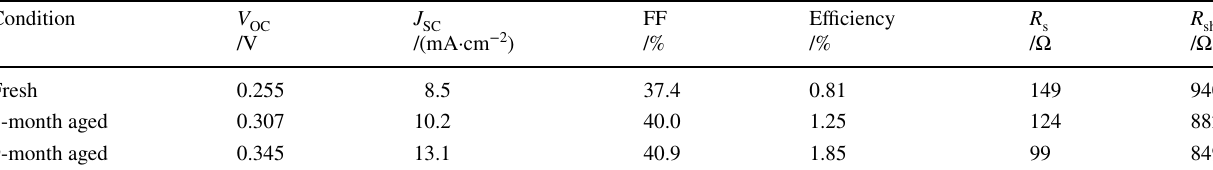
Device performance parameters of ZnO/Se 0.7 Te 0.3 solar cells for different aging times